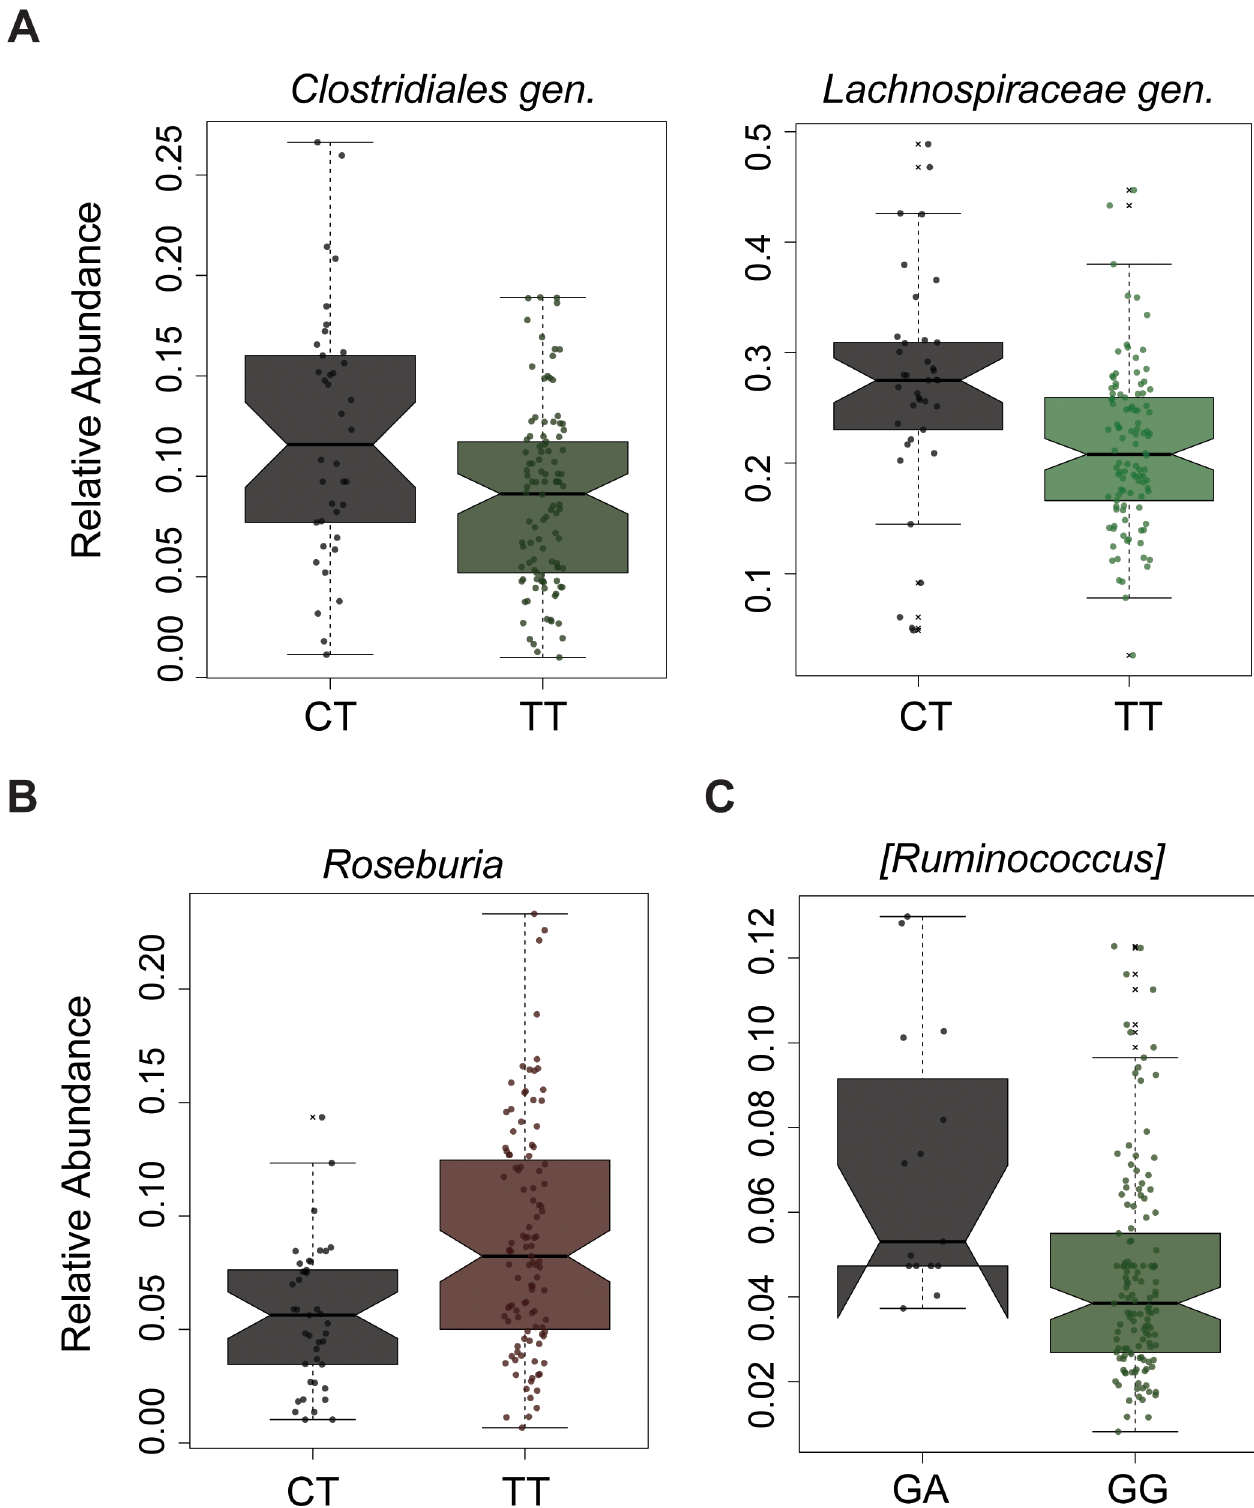
Fig 2. The microbial differences associated with disease and risk variants. The relative abundance of significantly different taxa (q < 0.05) were plotted for PTPN2 variant in (A) when analyzed for CD and in (B) when analyzed for UC. The relative abundance of significantly different taxa (q < 0.05) was plotted for PTPN22 variants when analyzed for UC (C) samples. The “ gen .,” was used for the classification of a distinct but unnamed genus in the Greengenes reference database and “unclassified” used for identification of unclassified taxa in Greengenes reference database, as previously used in another study [53]. https://doi.org/10.1371/journal.pone.0199664.g002 PLOS ONE | https://doi.org/10.1371/journal.pone.0199664 July 2,